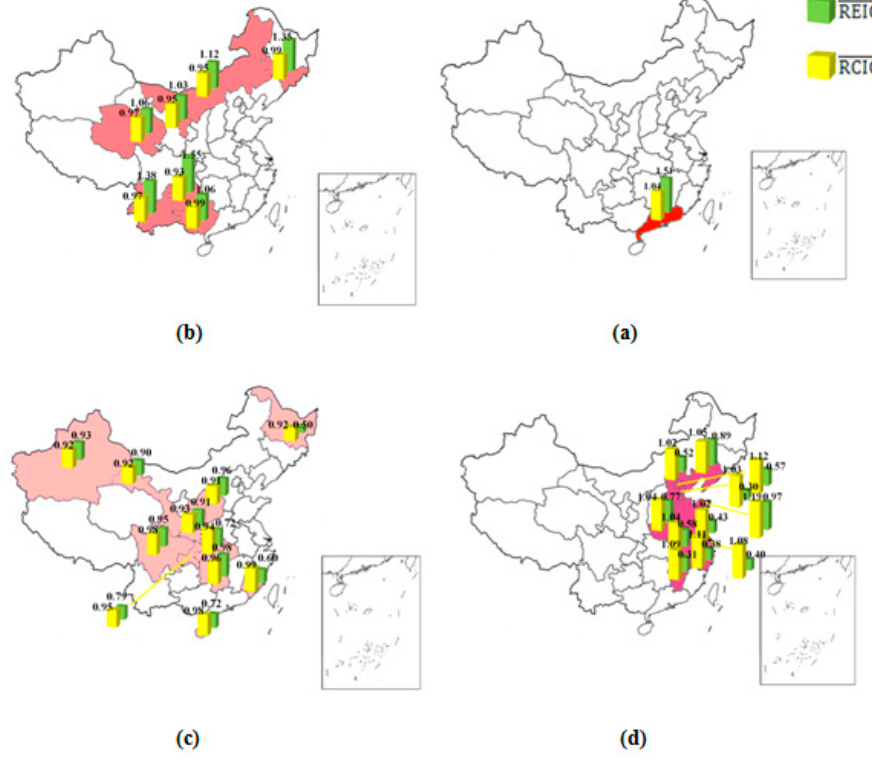
Figure 2. Map of different types of regions in China in 2010. ( a ) HH-type regions; ( b ) LH-type regions; ( c ) LL-type regions; ( d ) HL-type